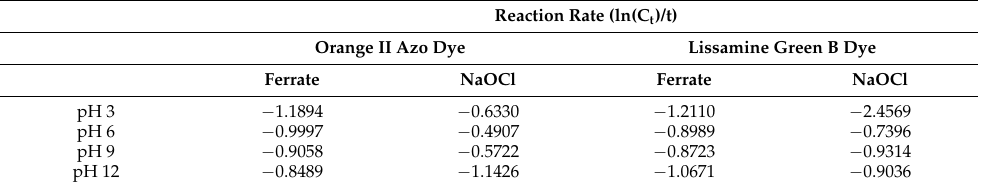
Table 1. Comparison of the removal rates of K 2 FeO 4 vs. NaOCl, and FeCl 3 · H 2 O for OD and LGB azo dyes.